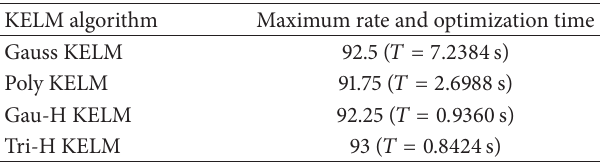
Table 3: The maximum testing rate (%) and the corresponding kernel parameter value.